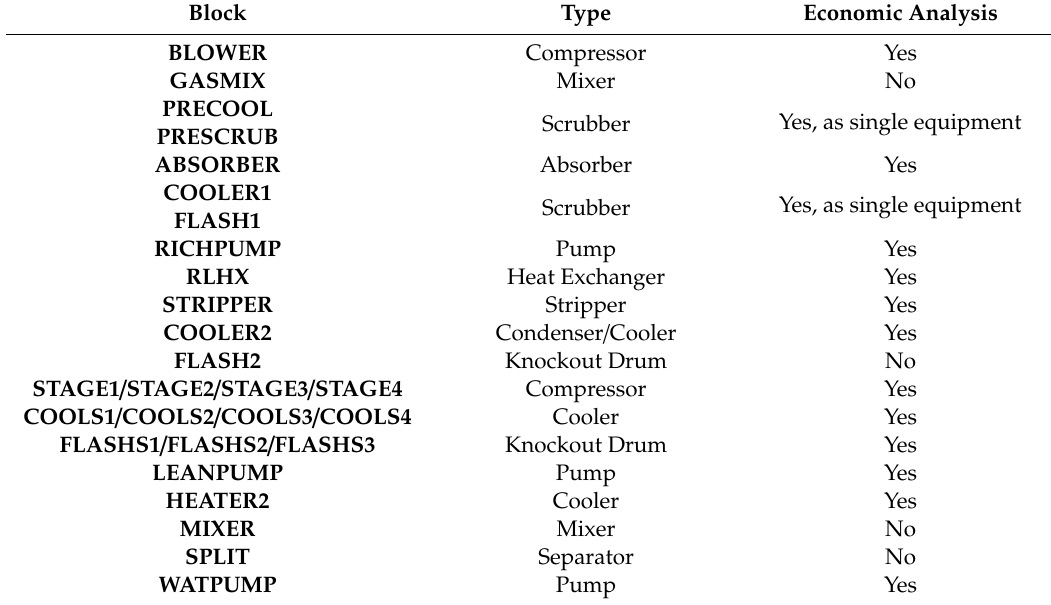
Figure A2. Flowsheet of the CO 2 capture plant model in Aspen Plus (II / II): CO 2 compression for transport and storage. Table A2. Aspen blocks, equipment type, and considerations in the economic analysis.